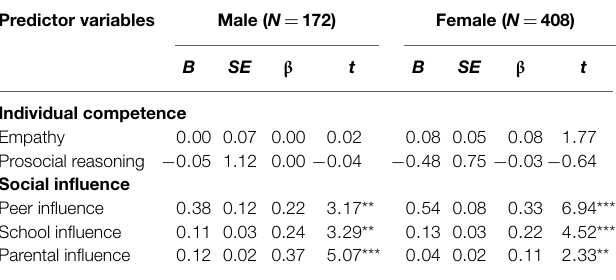
TABLE 4 | Prediction of helping intention from individual competence and social influence factors for males and females .